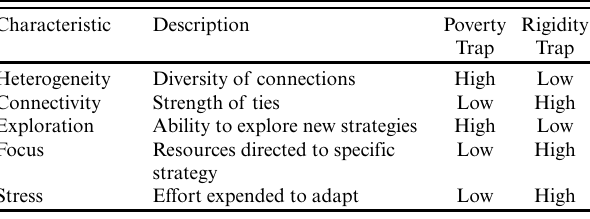
Table 1 . Characteristics of poverty and rigidity traps (adapted from Carpenter and Brock